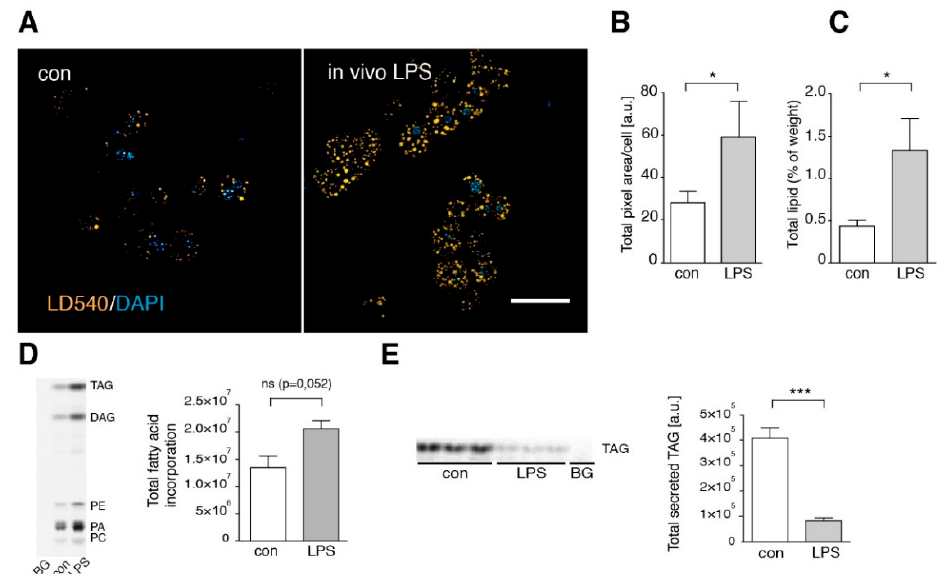
Figure 5. In vivo LPS treatment leads to hepatic steatosis. ( A ) Hepatocytes were isolated from in vivo LPS-treated (LPS) or untreated (control) mice. Cells were stained with LD540 and DAPI to visualize lipid droplet (LD). Scale bar: 50 µ M. ( B ) Quantification of the total fluorescent LD area per cell ( n = 3). ( C ) Averaged total lipids (weight %) in livers of control (con) and LPS-treated animals (LPS) ( n ≥ 4). ( D ) To determine fatty acid incorporation, hepatocytes were incubated with alkyne fatty acids for 10 min. Lipids were extracted and labeled lipids analyzed as described in Experimental Procedures. Left: image of a representative TLC plate. Right: quantification of total fluorescent lipids / lane ( n = 3). ( E ) For determination of VLDL secretion, chase medium was collected after 2 min alkyne fatty acid pulse and 120 min chase time, analyzed as above, and the amount of VLDL was determined from the TAG signal. Left: Image of the TLC plate, right: quantification of total secreted TAG ( n = 3). Data are visualized as mean values with SEM. Significance was analyzed with a two-tailed Student’s t -test. Statistical significance is indicated as follows: ns, not significant, * p < 0.05, *** p < 0.001.